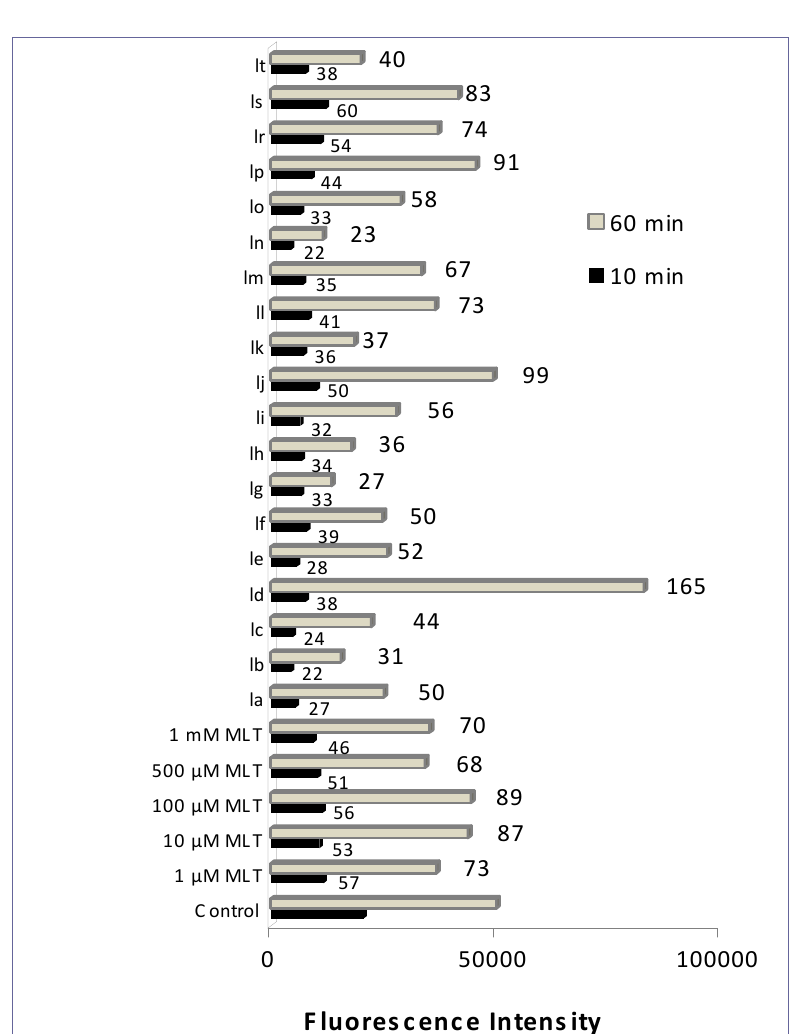
Figure 2. Oxidation of DCFH via ROS in erythrocytes after the incubation with various concentrations of MLT or 10 µM synthesised indole derivatives for 10 and 60 min.